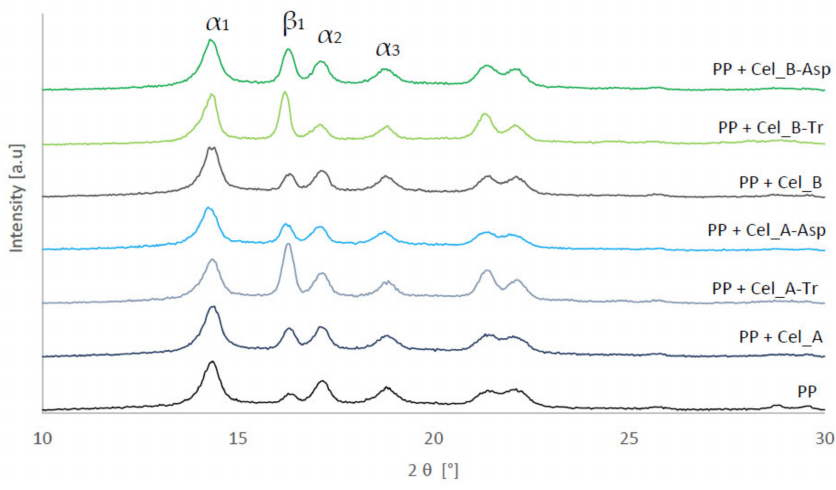
Figure 6. Diffractograms of polypropylene matrix and composite materials. Table 5. The content of the β -PP form in composite systems and polypropylene